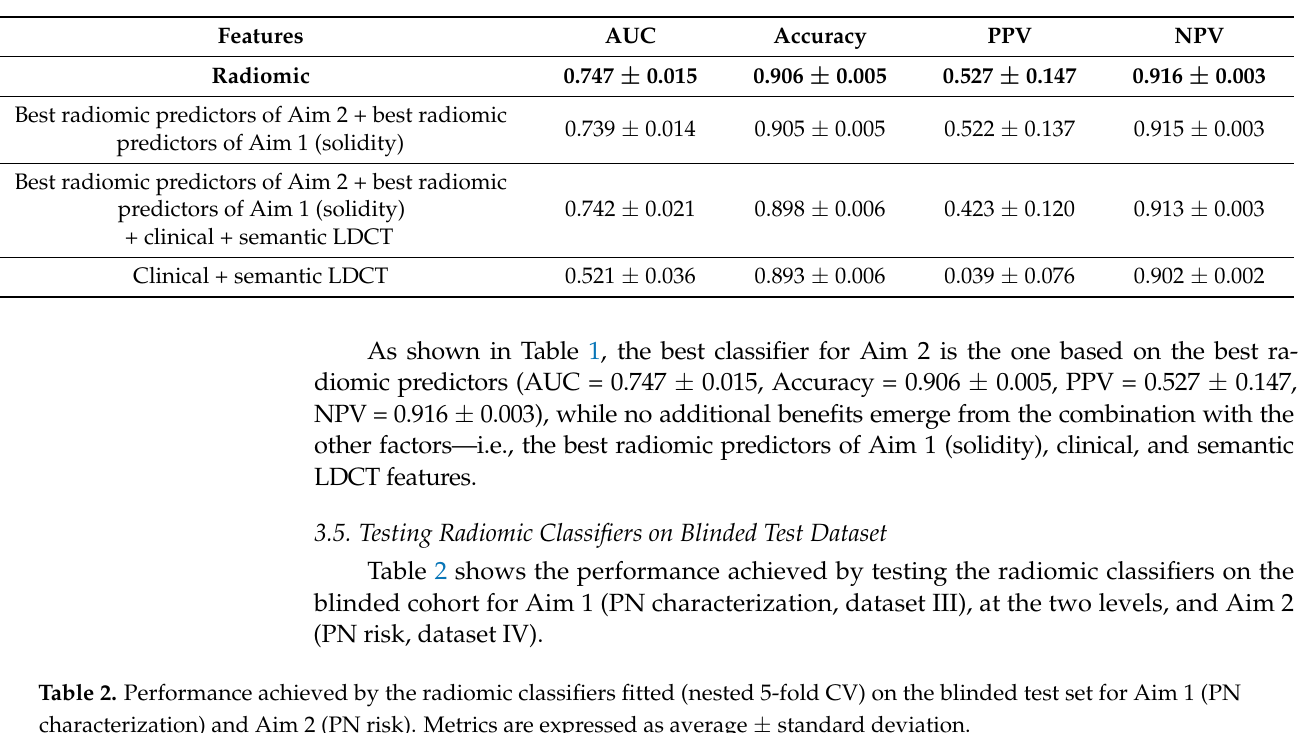
Table 1. Results on Aim 2 were achieved by incrementally integrating the best radiomic predictors of Aim 2 with the best radiomic predictors of Aim 1 (solidity), available clinical and semantic LDCT radiological features. Values in boldface denote the best configuration.